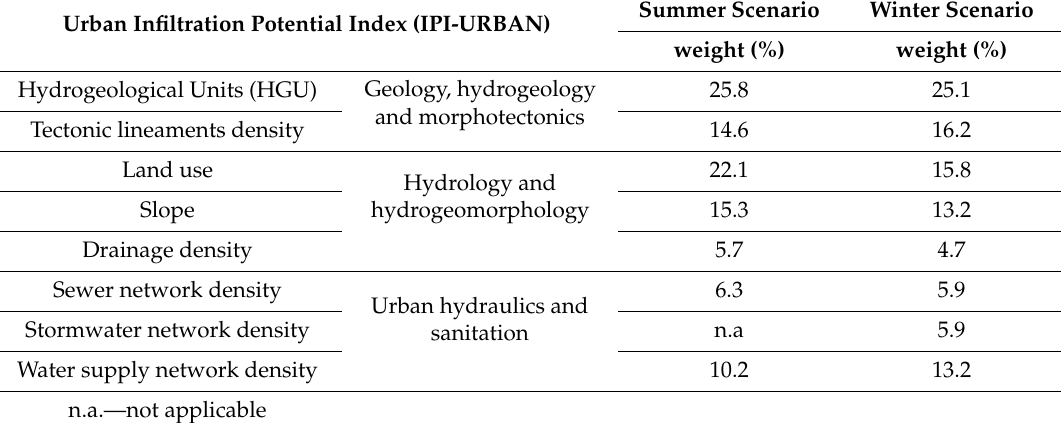
Table 1. Infiltration Potential Index in Urban Areas (IPI-Urban): Relative weight of the factors for each scenario (updated from Reference